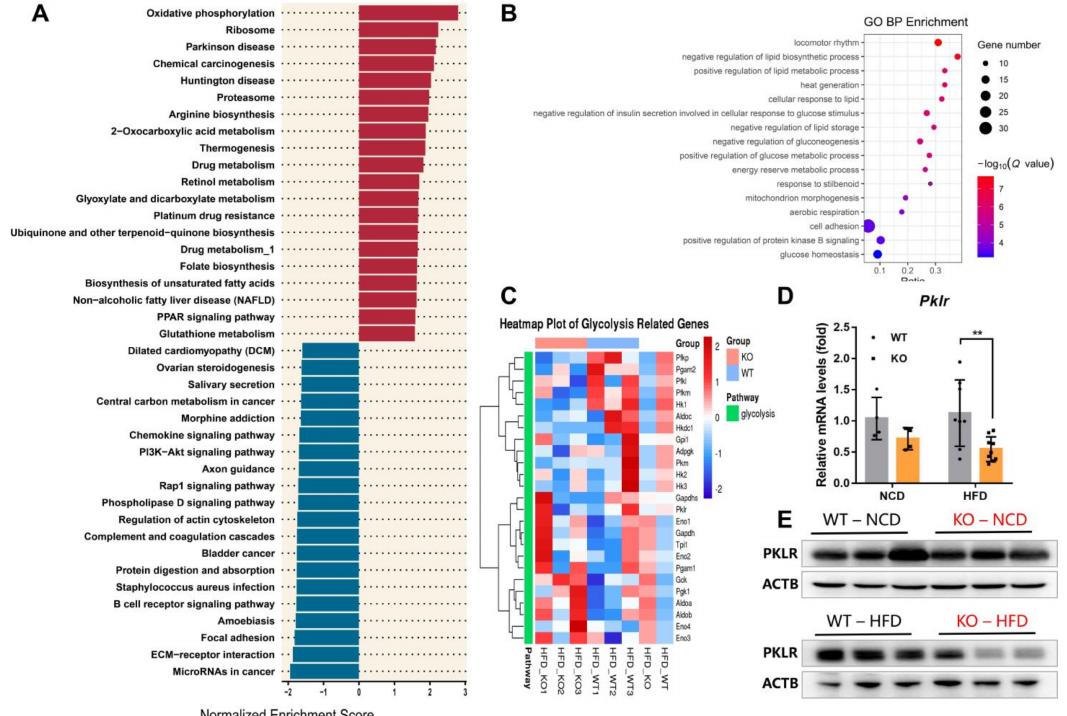
Figure 4. Deletion of miR-23b/27b/24-1 cluster decreases pyruvate kinase. ( A ) Top 20 dysregulated gene sets of RNA-seq data. ( B ) Gene Ontology (GO) enrichments analysis of dysregulated expressed genes ( q -value < 0.001). ( C ) Heatmap of glycolysis-related genes. ( D ) qPCR of Pklr between WT and KO mice fed an NCD ( n = 4) or an HFD ( n = 8–9). ( E ) Protein expression of PKLR with miR-23b/27b/24-1 cluster ablation in the liver ( n = 3). Data were represented as mean ± SD. Significance was determined by Student’s t -test analysis, ** p <